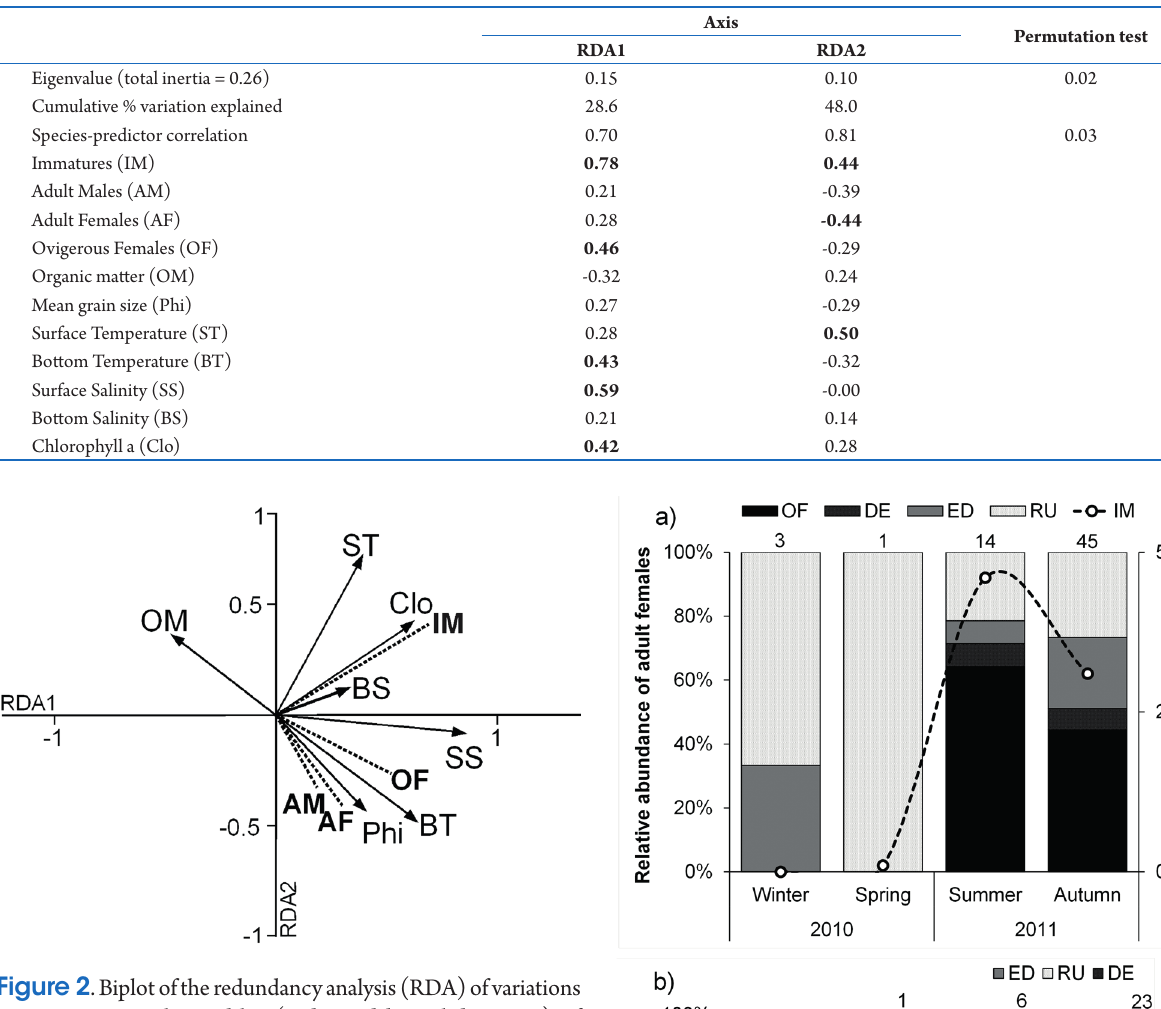
Table 3 . Summary of Results of Redundancy Analysis (RDA) for demographic groups of Achelous spinimanus in an upwelling region off southeastern Brazil. Variables that were considered to be biologically meaningful for that RDA axis are indicated in bold (i.e. ≥ 0.4; Rakocinski et al ., 1996).